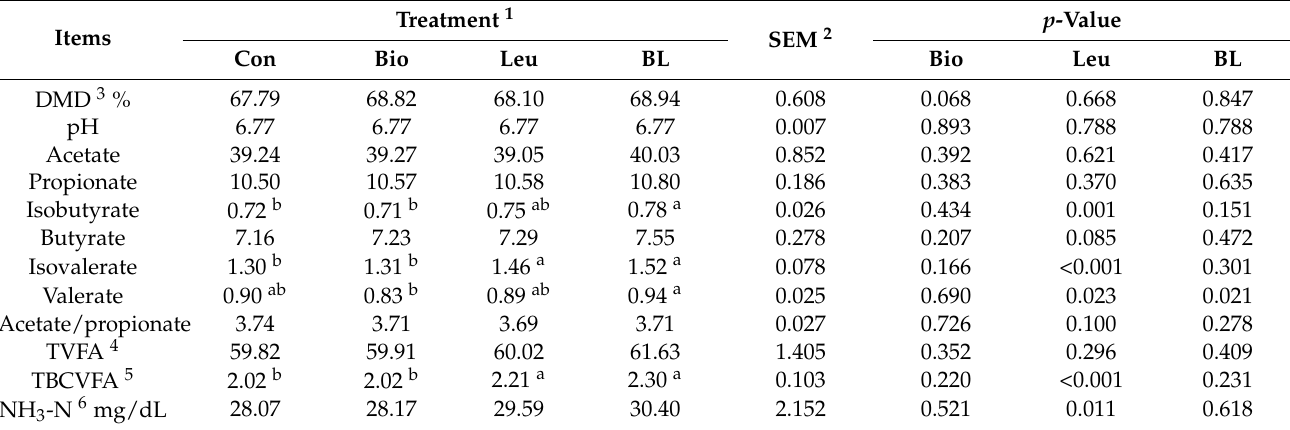
Table 2. Effects of biotin and leucine supplementation on fermentation parameters in vitro